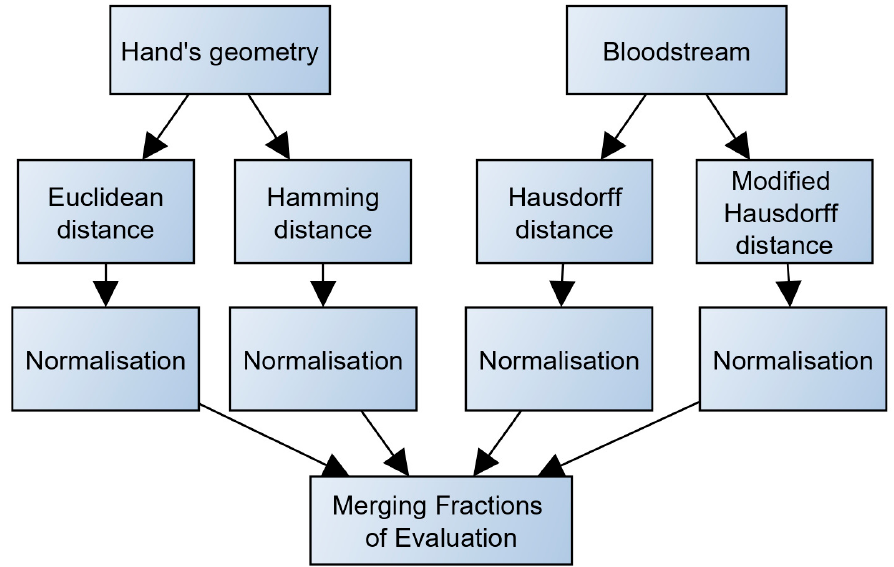
Figure 9. Calculation of fractional metrics evaluation.